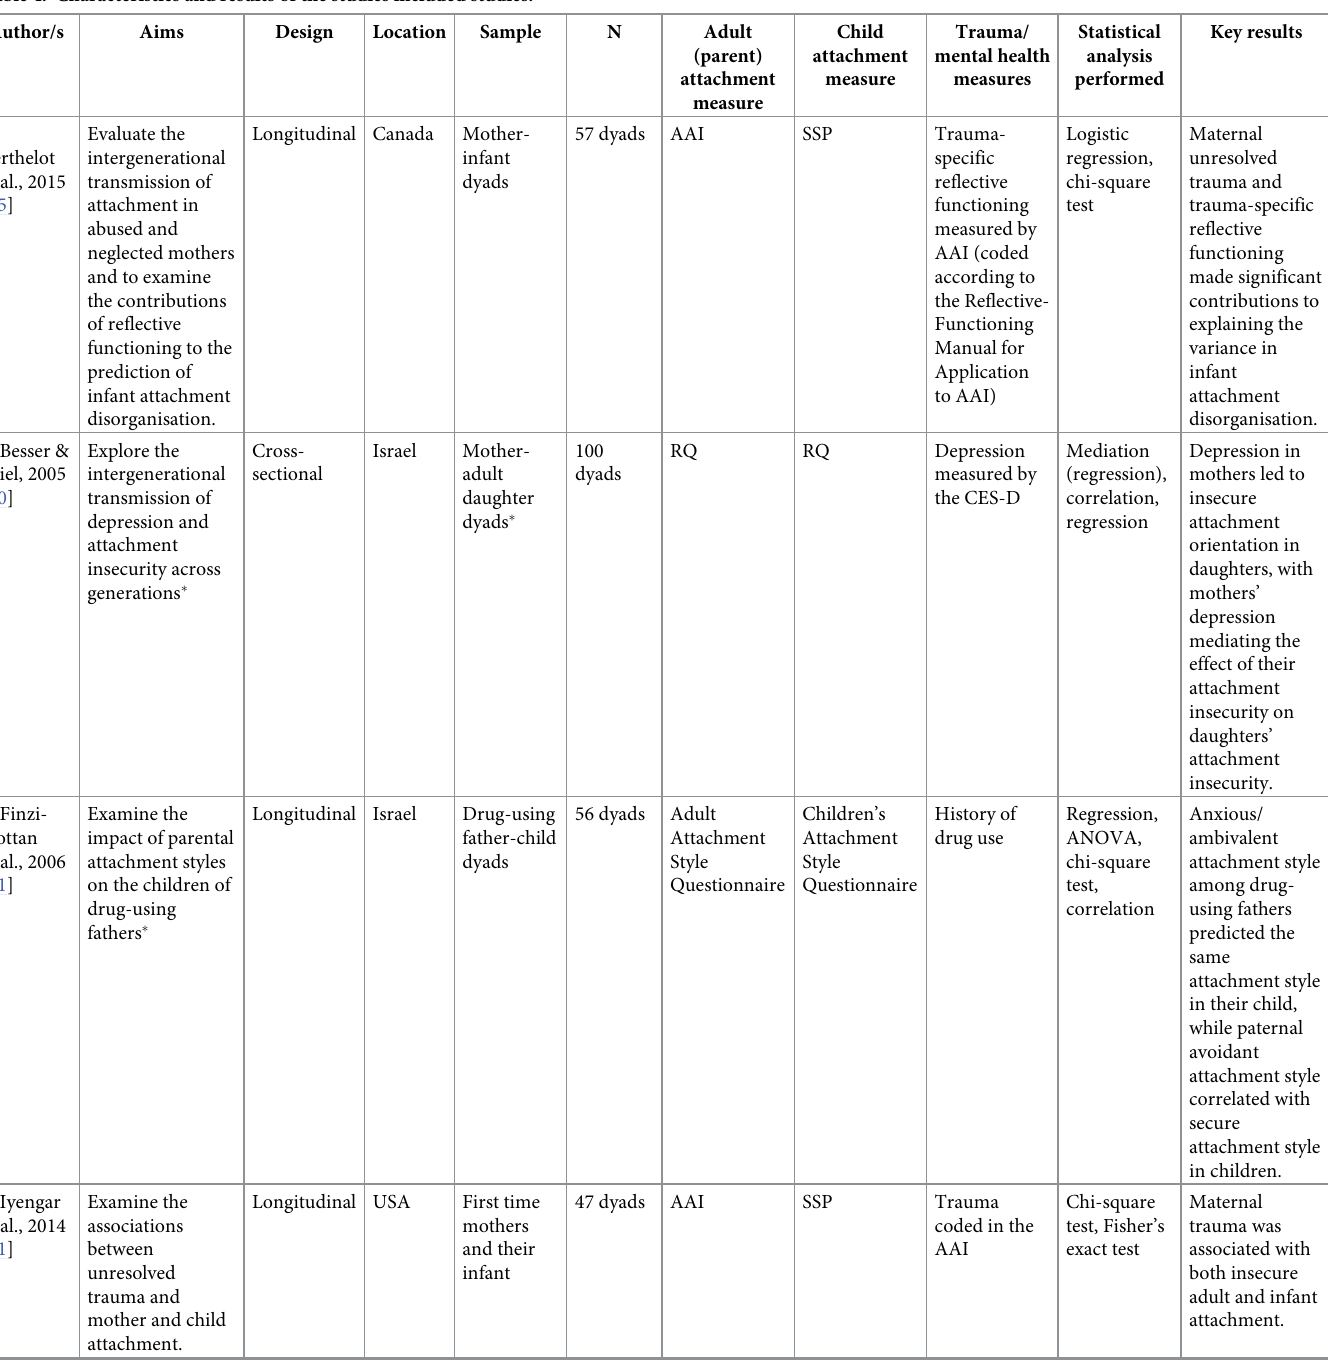
Table 4. Characteristics and results of the studies included